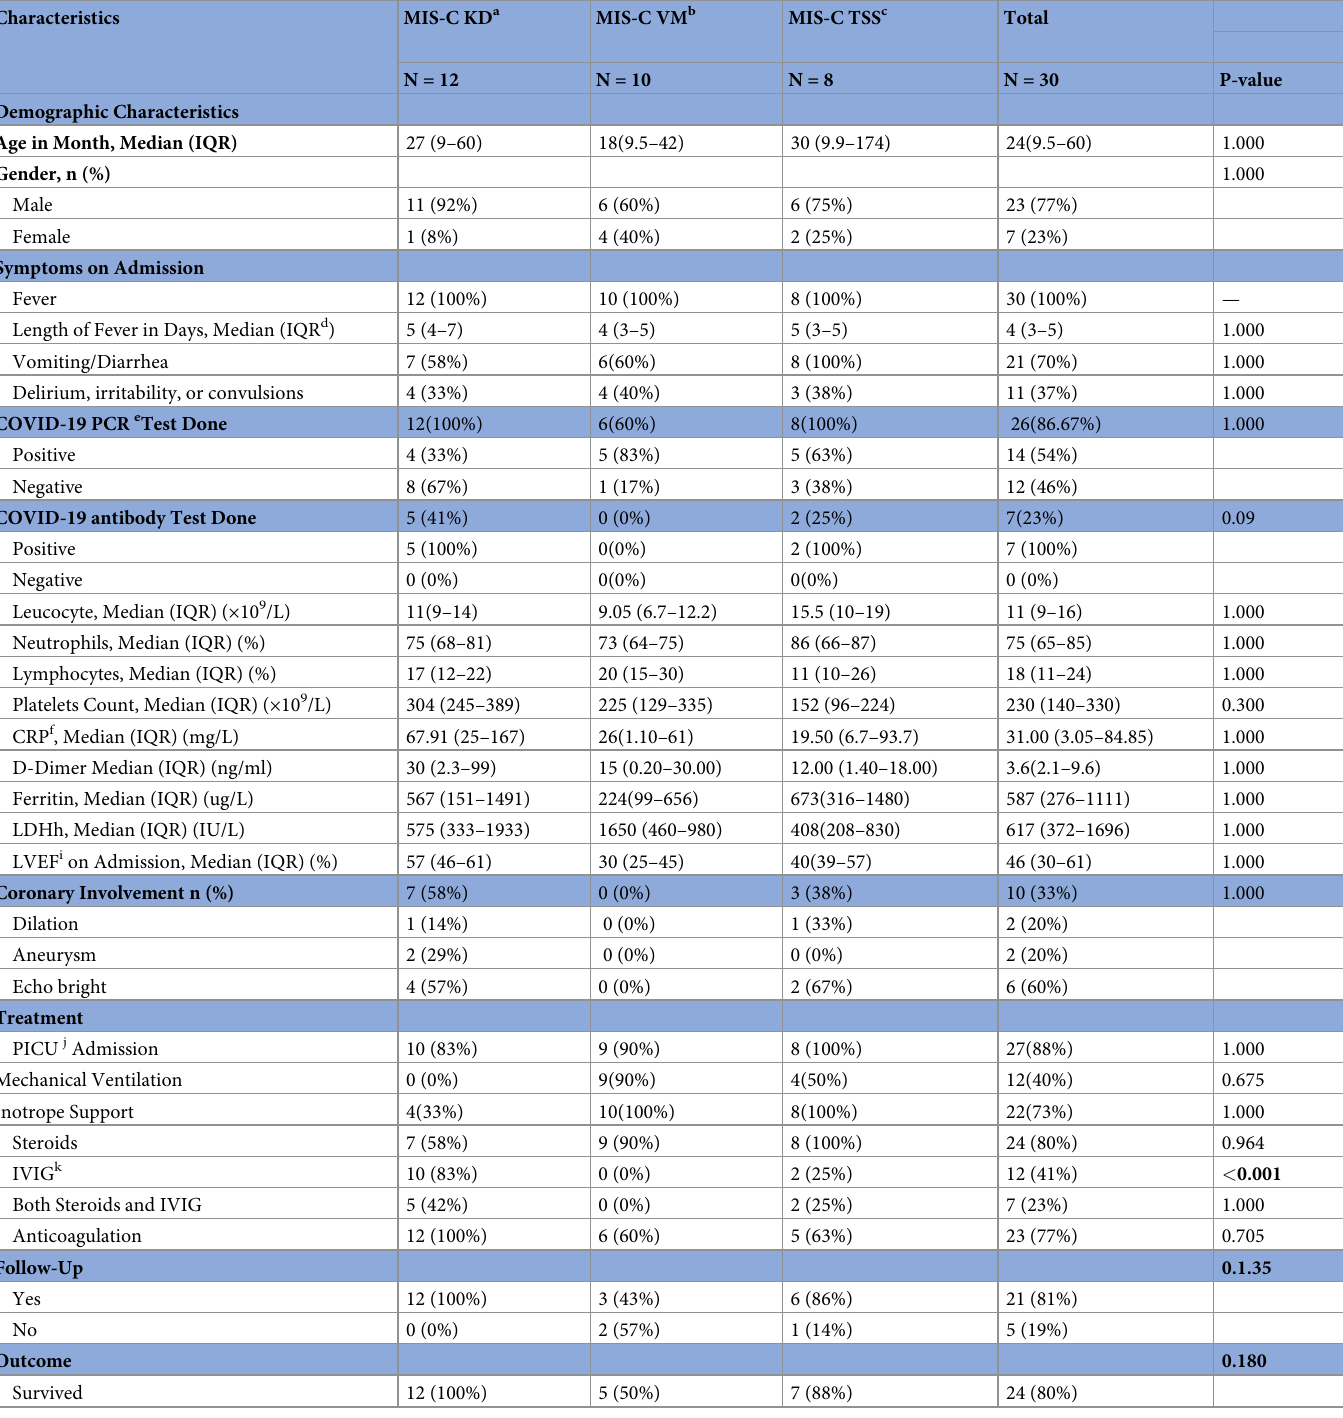
Table 2. Comparison of clinical and laboratory features of children presenting with multisystem inflammatory syndrome (MIS-C) (n = 30).